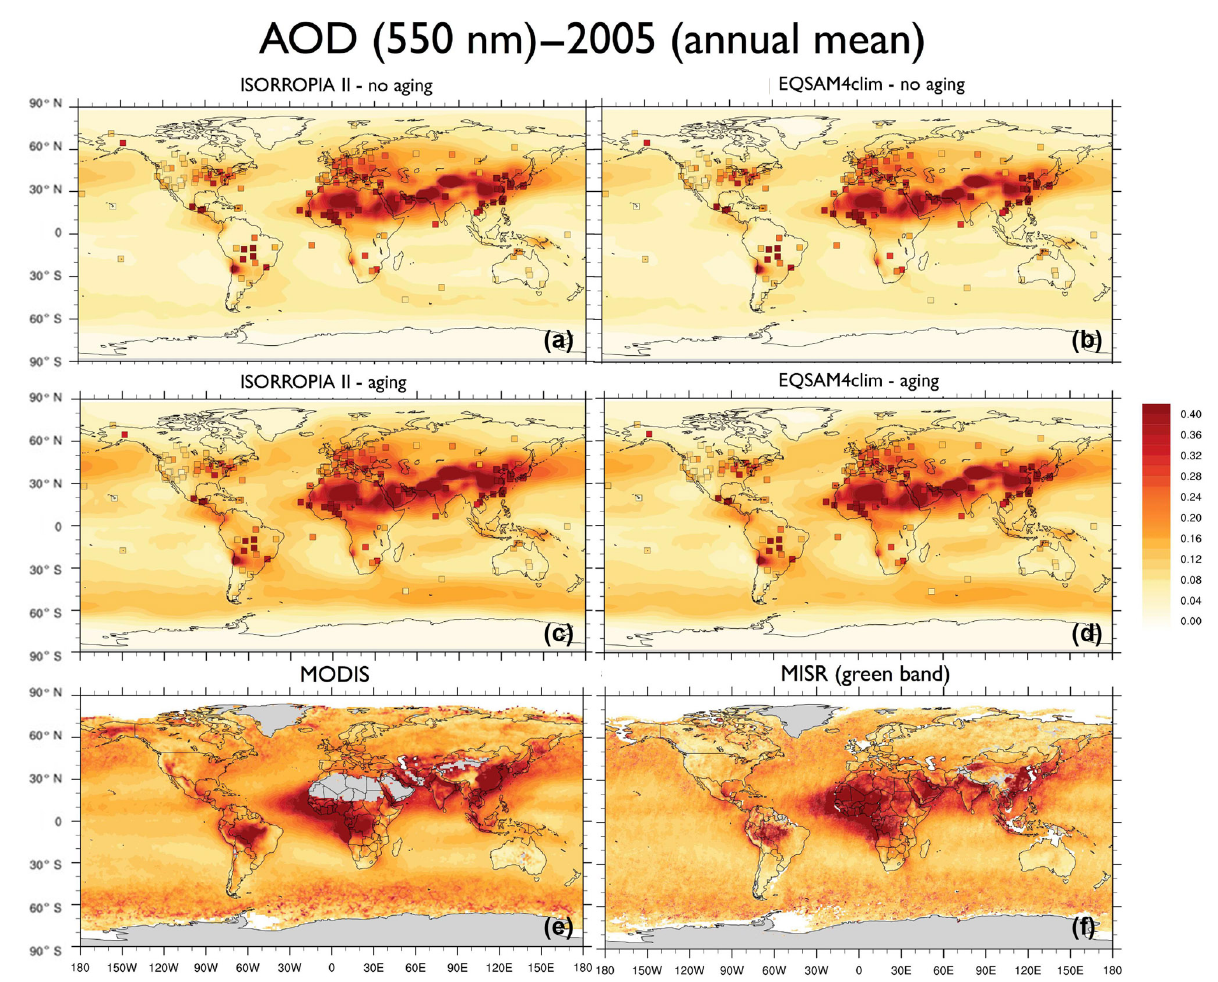
Figure 12. EMAC model AOD results for the year 2005 (annual mean) based on ISORROPIA II (a, c) and EQSAM4clim (b, d) . (a, b) No aging and (c, d) aging cases. AERONET ground station observations are included as squares (same color scale). (e, f) Satellite observations by MODIS (e) and MISR (f) (550nm, annual mean 2005). MODIS monitors the ambient AOD from space and provides data over the oceans and, except deserts, also over continents (http://modis-atmos.gsfc.nasa.gov/, last access: 23 November 2018). The MISR aerosol product is available globally (products can be obtained from http://disc.sci.gsfc.nasa.gov/giovanni, last access: 23 November